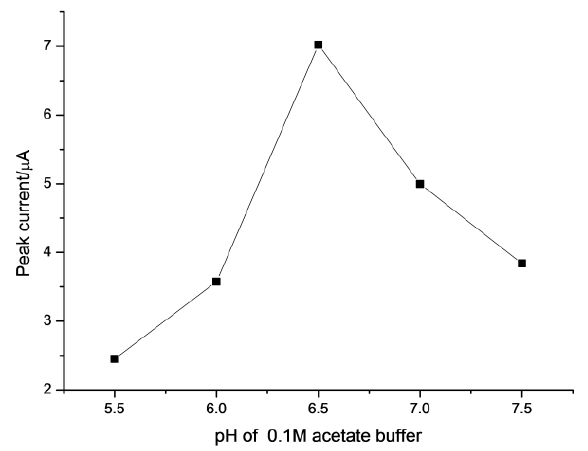
Figure 5. Effect of the pH on the LPME extraction efficiency of 1 ng L − 1 Al(III). LPME conditions are as in Figure 3 except the pH of the solution. The parameters of SW-ASV are same as Figure 4.